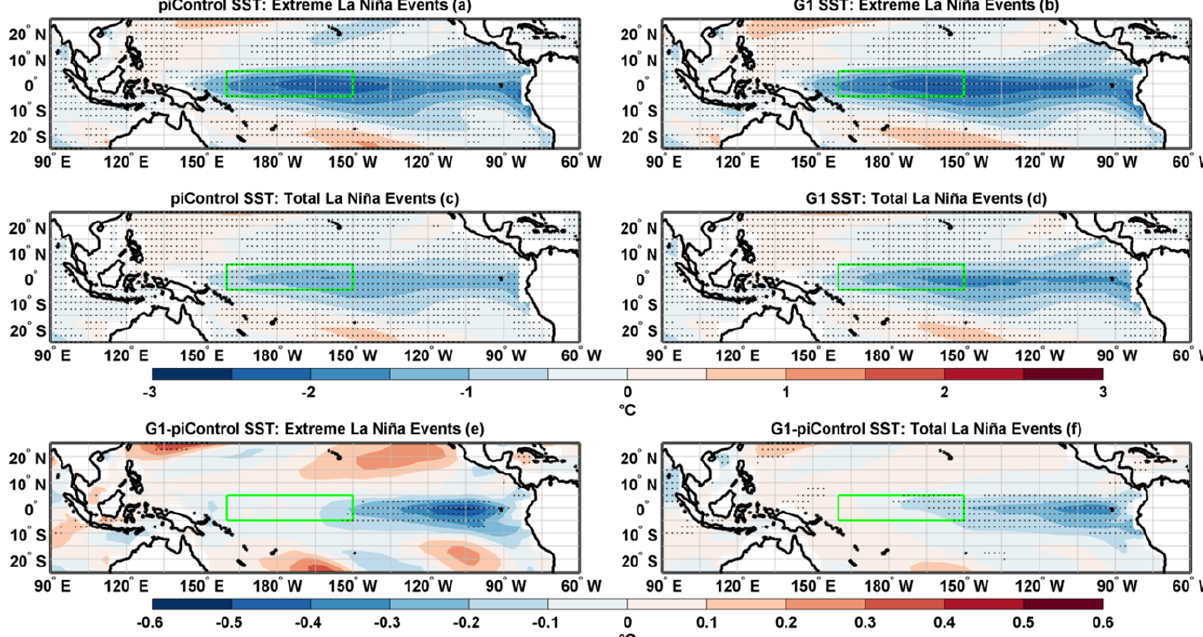
Figure 12. Composites of SST anomalies for extreme La Niña events in (a) piControl and (b) G1. Composites of SST for the total number of La Niña events in (c) piControl and (d) G1. Composite differences (G1 − piControl) of SST for (e) extreme La Niña events and (f) the total number of La Niña events. Stipples indicate grid points with statistical significance at 99%cl using a non-parametric Wilcoxon rank-sum test. The green box indicates the Niño4